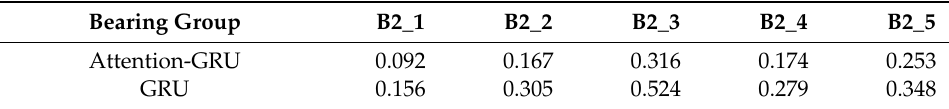
Table 5. RUL prediction error of attention-GRU and